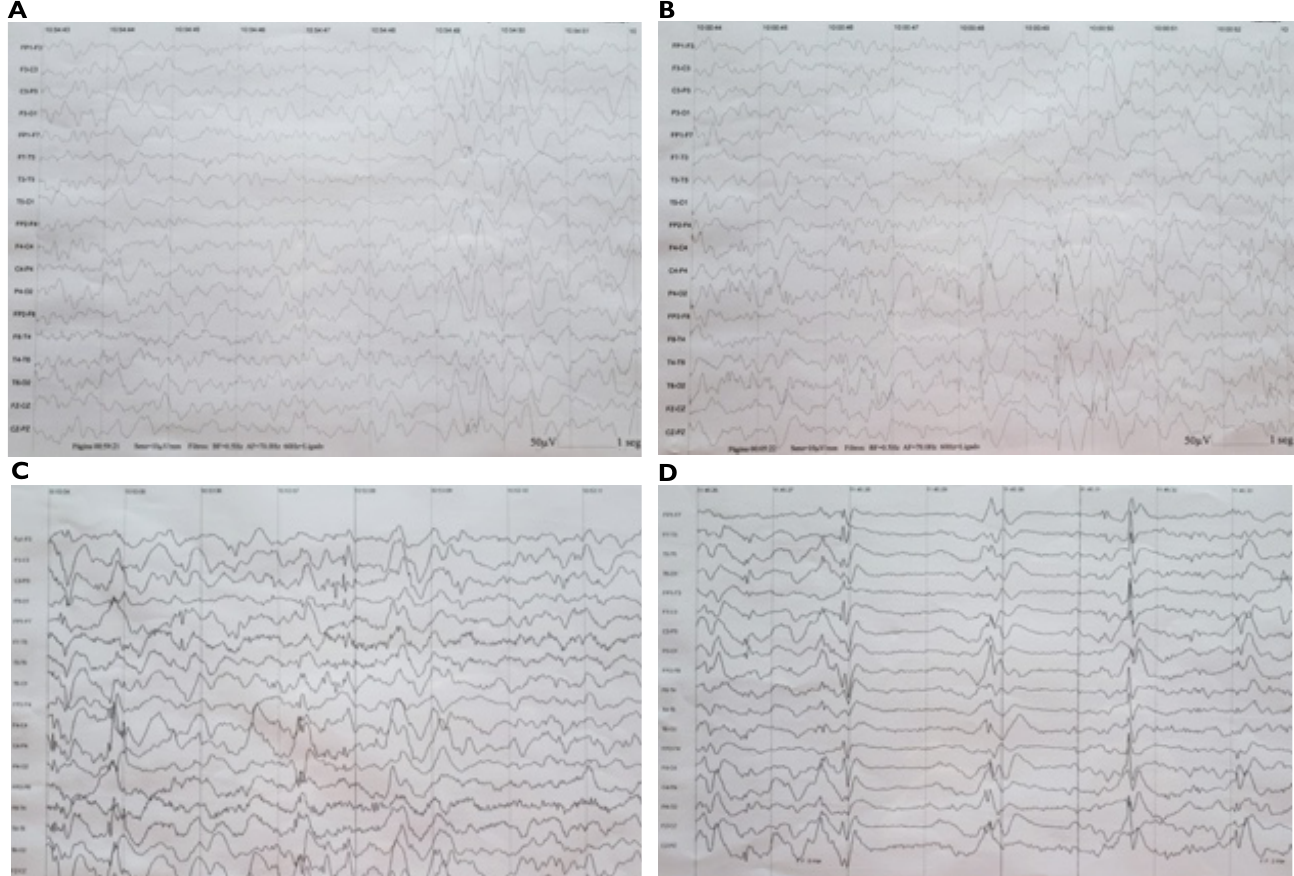
Figure 1. Electroencephalographic evaluation (EEG) in the CLN2 patient. All EEG showed slow background activity with absence of spindles during sleeping record and absence of alpha rhythm during awake record. At 1 year after disease onset, independent parietooccipital spikes on both sides in waking stage (Panel A), and during sleep (Panel B). At 3 years after disease onset, multifocal spikes were recorded (Panels C). At 4 years after disease onset, multifocal spikes and frequent generalized spike wave with attenuated segments (Panel